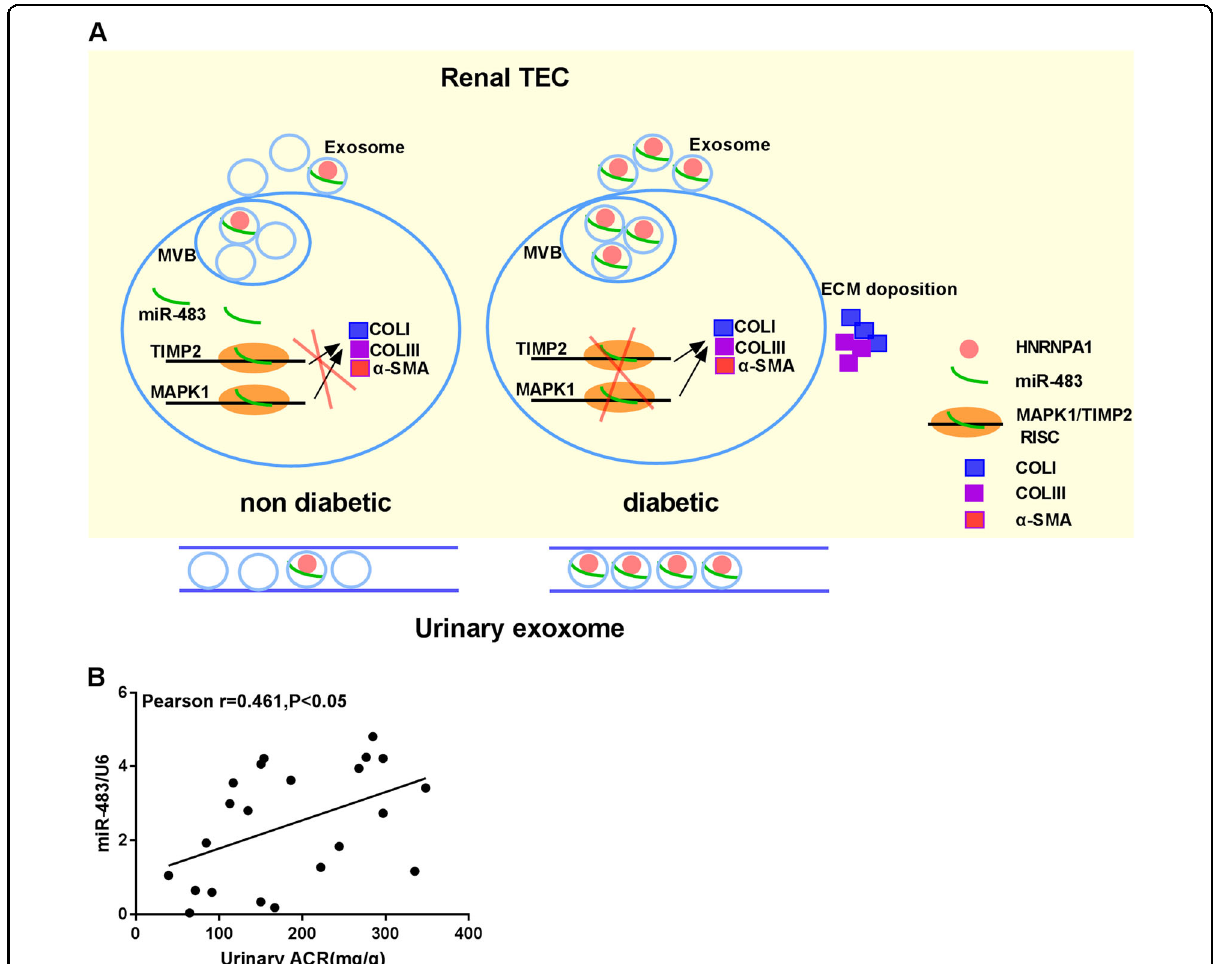
the renal tubular epithelial cells, and only a small amount of miR-483 was encapsulated into MVB (multivesicular body, vesicles) and was secreted into the extracellular through exosomes. Therefore, the intracellular miR-483 blocked ECM synthesis by restraining the TIMP2/MAPK1 pathway; Under pathological conditions, most miR-483 was encapsulated into MVB and was secreted into the extracellular domain through exosomes and transferred into the urine. Therefore, miR-483 was highly expressed in the urinary exosomes, and the lack of miR-483 in renal tubular epithelial cells led to the activation of the TIMP2/MAPK1 pathway, thus promoting ECM synthesis. B Pearson correlation coef fi cient analysis of the correlation between urinary ACR and urinary exosome miR-483-5p. Pearson correlation coef fi cient analysis of three independent